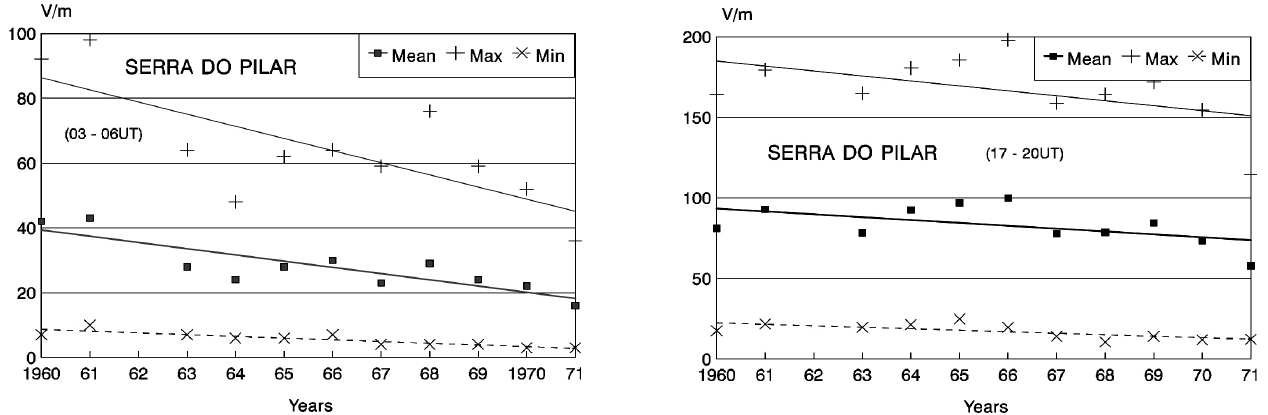
Fig. 1. Atmospheric Potential Gradient (PG) measurements obtained at Serra do Pilar (Portugal) (a) Changes in dawn values of PG (based on data from 03:00 to 06:00 UT) between 1960 and 1971. (b) As Fig. 1a, but for evening PG values (based on data from 17:00 to 20:00